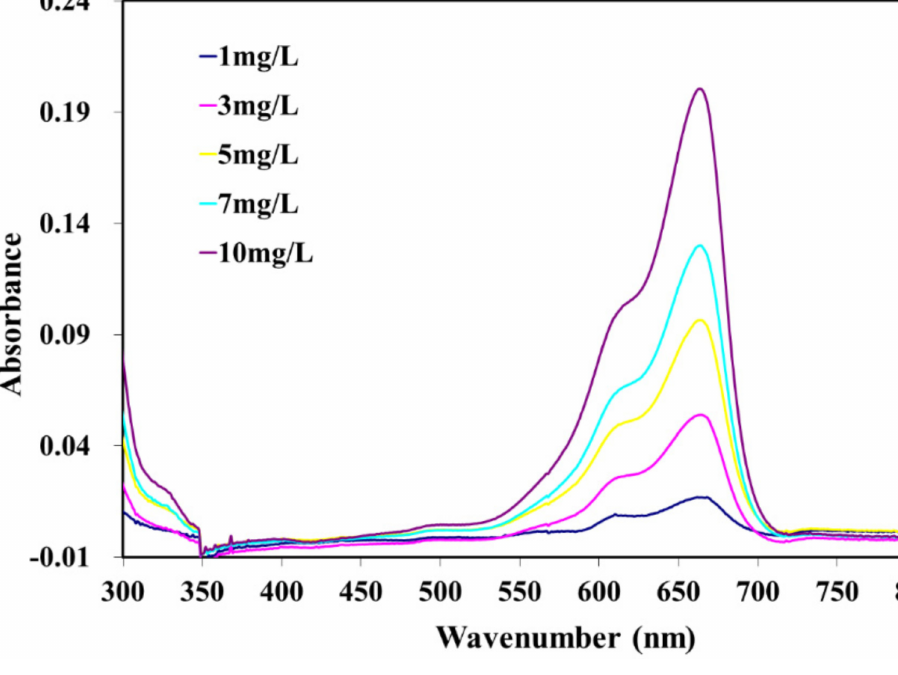
Figure 3. Wavelength–absorbance curves of methylene blue (MB) aqueous